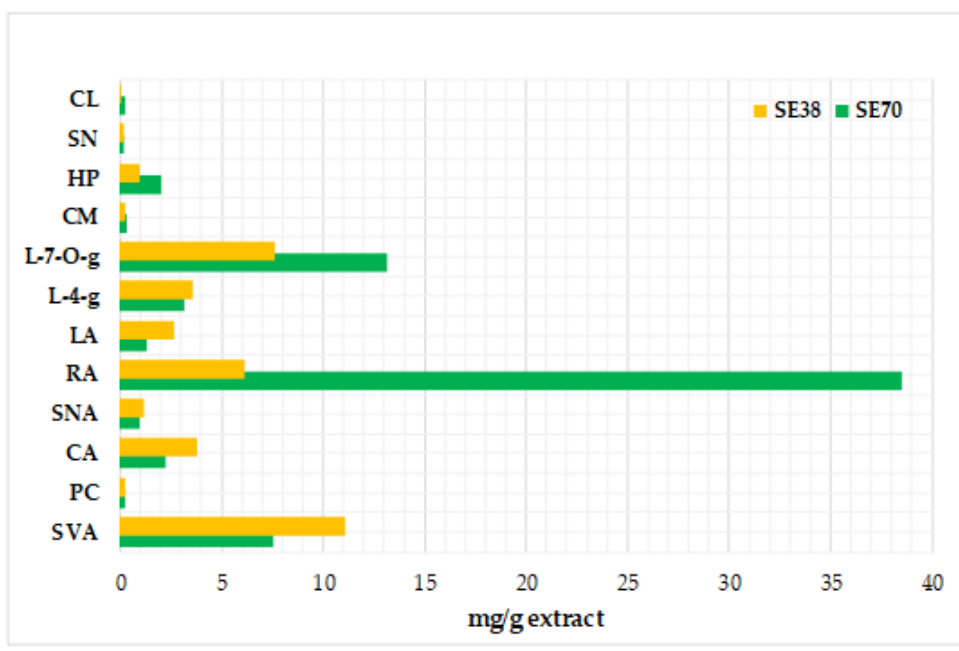
Figure 1. Polyphenol profile of sage extracts (SE38 and SE70) [14]. Abbreviations: SVA: salvianic